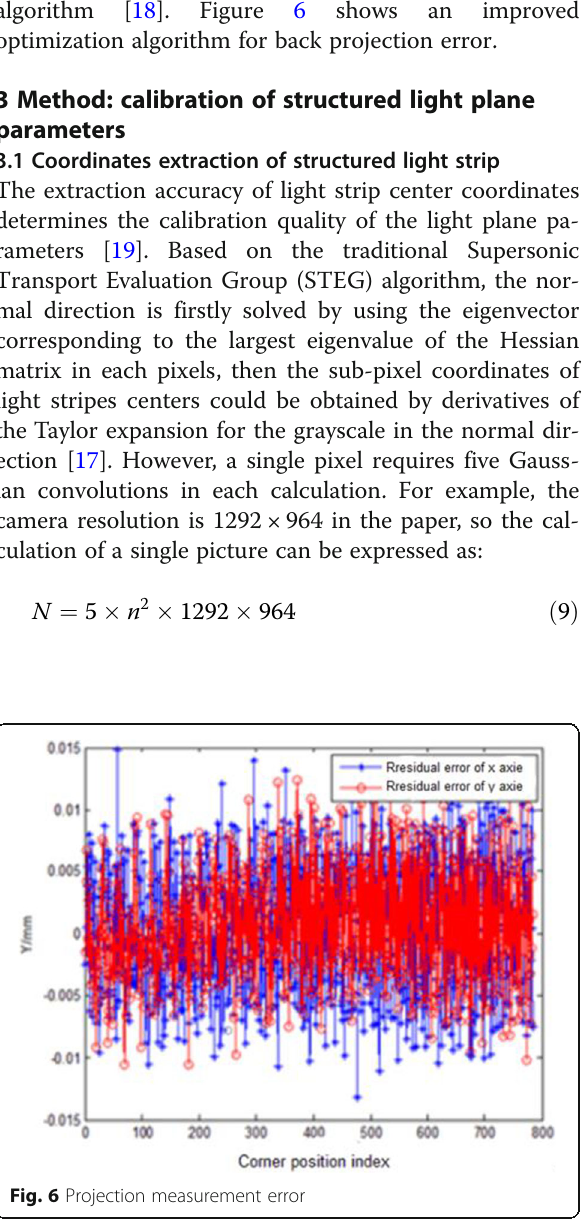
function can be solved using the Levenberg-Marquardt algorithm [18]. 6 shows an improved optimization algorithm for back projection error.